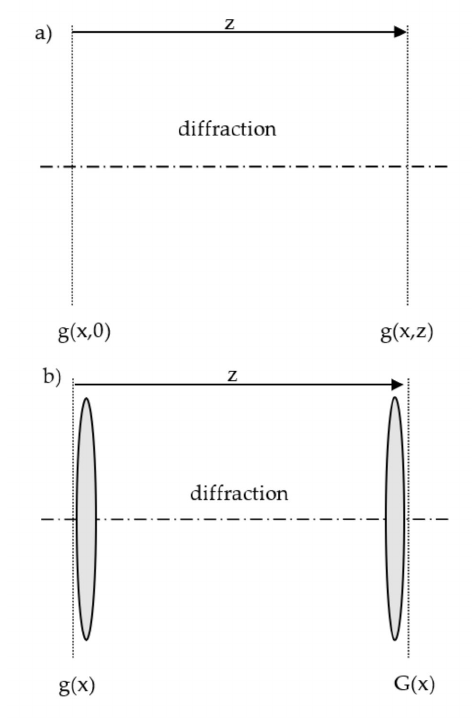
Figure 2. Diffraction in free space, in the presence of lenses, as well as without them: ( a ) the field g ( x , z ) observed after diffraction at a certain distance z in free space (Fresnel transform). ( b ) By adding two lenses, diffraction results in the Fourier transform G ( x ) of the object g ( x ). The focal length of the identical lenses should be equal to the observation distance z